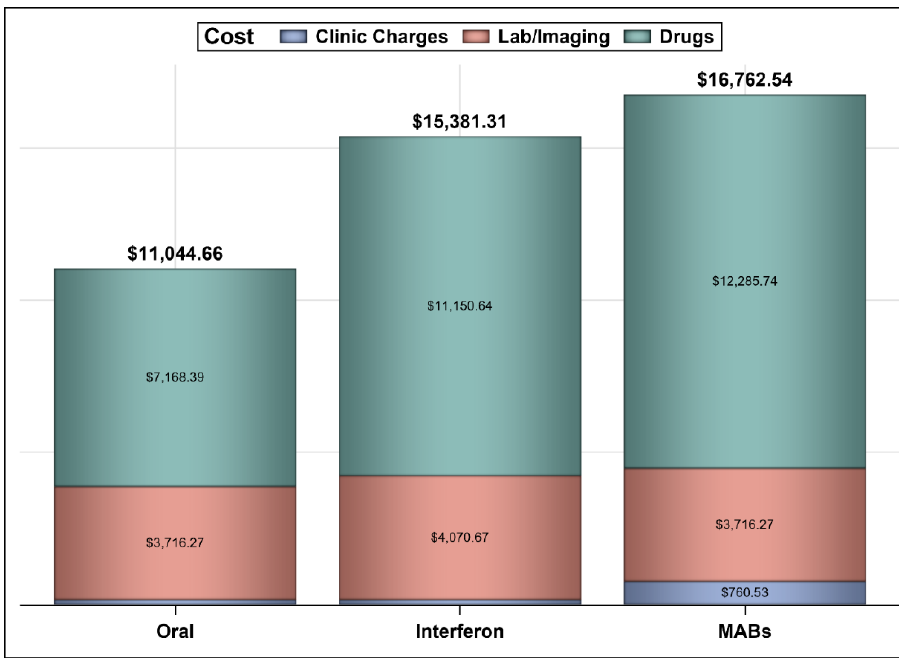
Figure 2. The mean annual costs of oral agents, interferon, and MABs. Table 3. The mean effectiveness rates and costs of oral, interferon, and monoclonal antibodies-based